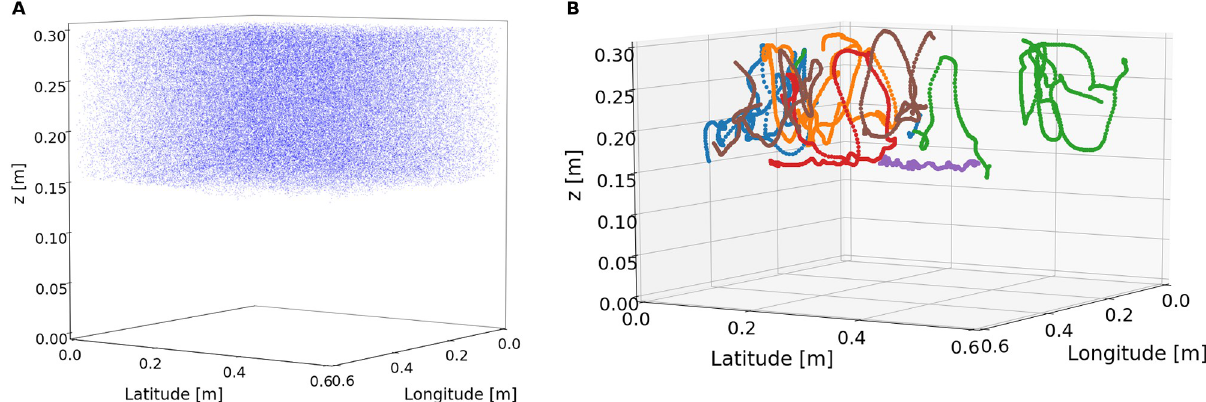
Fig 8. Microbial motion within the simulated flow. (a) A snapshot of microbe positions at t = 25 s of the ( B , v swim ) = (5 s, 10 μ m s − 1 ) motile simulation. (b) Sample of six 3D microbe trajectories from t = 0–60s in the ( B , v swim ) = (5 s, 10 μ m s − 1 ) motile simulation. Each uniquely-coloured sequence of dots represents a single microbe’s trajectory. Owing to the periodic boundaries in the longitudinal and latitudinal directions, trajectories may appear discontinuous when a microbe moves through such a boundary (e.g. green trajectory). Microbes spent time in each of the three depth regions considered in our analysis, mostly due to advection by the surrounding fluid, but also through individual locomotion in less fast-moving regions of the fluid. In particular, long sojourns were noticeable at greater depths where turbulent fluid motion is less